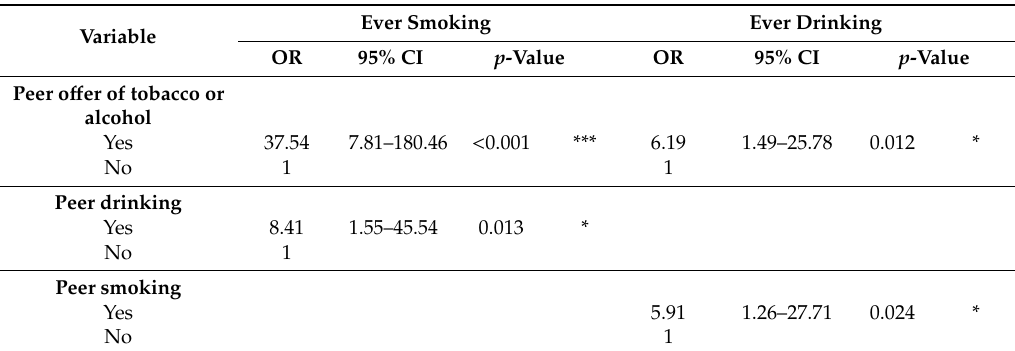
Table 4. Factors associated with ever smoking and ever drinking among the adolescents through logistic regression analysis (forward